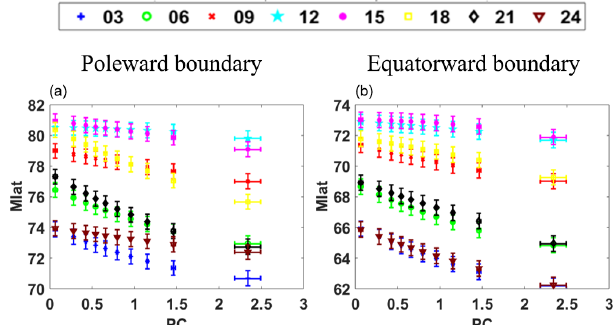
Figure 8. Response of the magnetic latitude of poleward (a) and